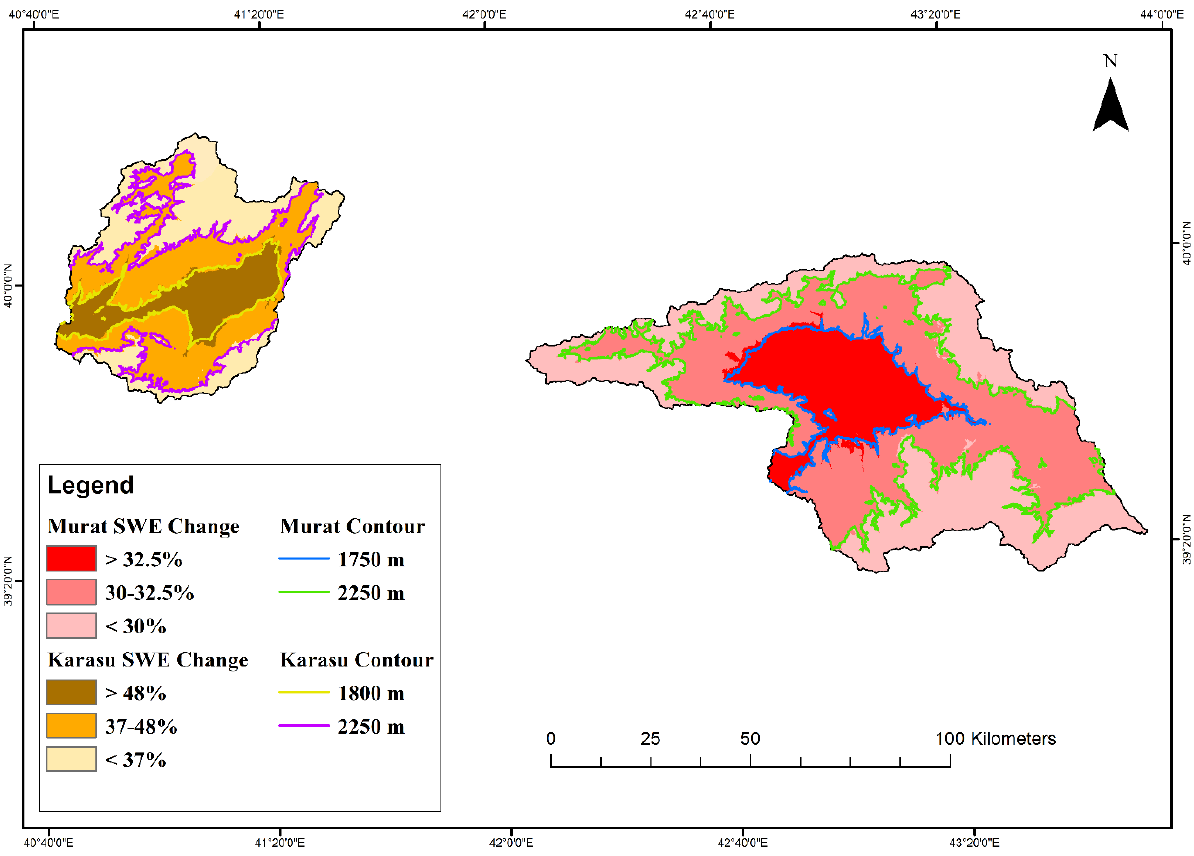
Figure 11. Percent SWE change rates in different elevation zones for 2071–2099 (2nd period) of RCP8.5 emission scenario. Table 13. Detecting climate change impacts for runoff outputs in different scenarios and periods. Murat Reference CT: